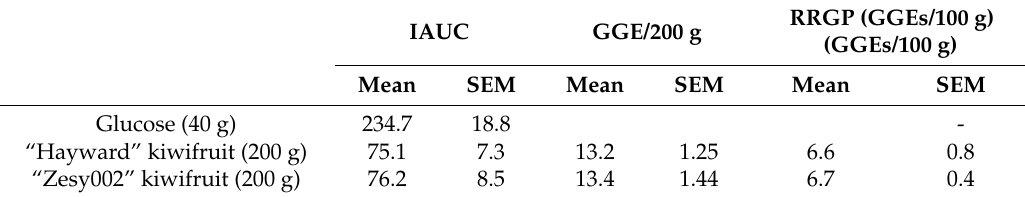
Table 4. Relative glycaemic potency (RGP) expressed as grams of glucose equivalents (GGEs) per 100 g of kiwifruit, determined from the relative areas under the blood glucose response curves (incremental area under the curve, IAUC) shown in Figure 2.